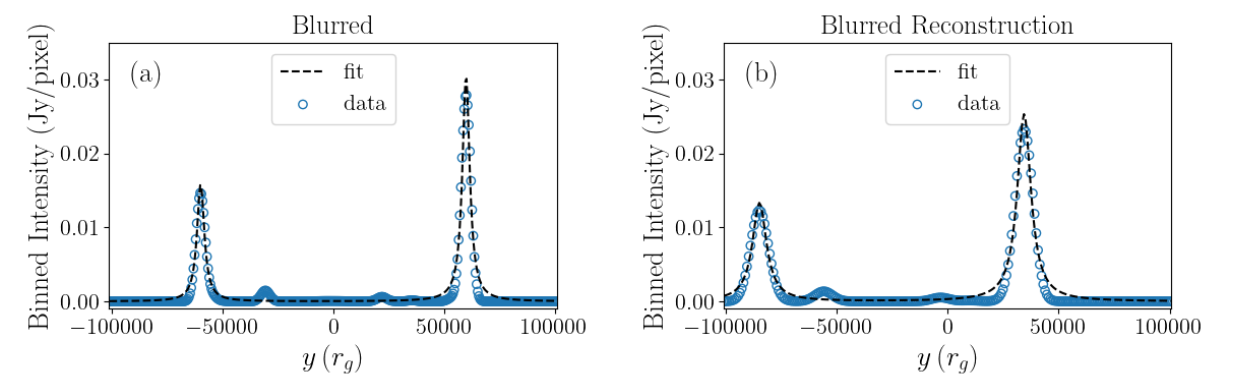
Figure A5. We demonstrate the fit performance using a ray-traced image of model m7a0.9-HR at t = 78,000 t g , θ = 90 ◦ , D = 10 Mpc, and R = 20. We show the x -binned data and a double Lorentzian (Equation (A1)) fit for ( a ) the blurred base image and ( b ) the blurred